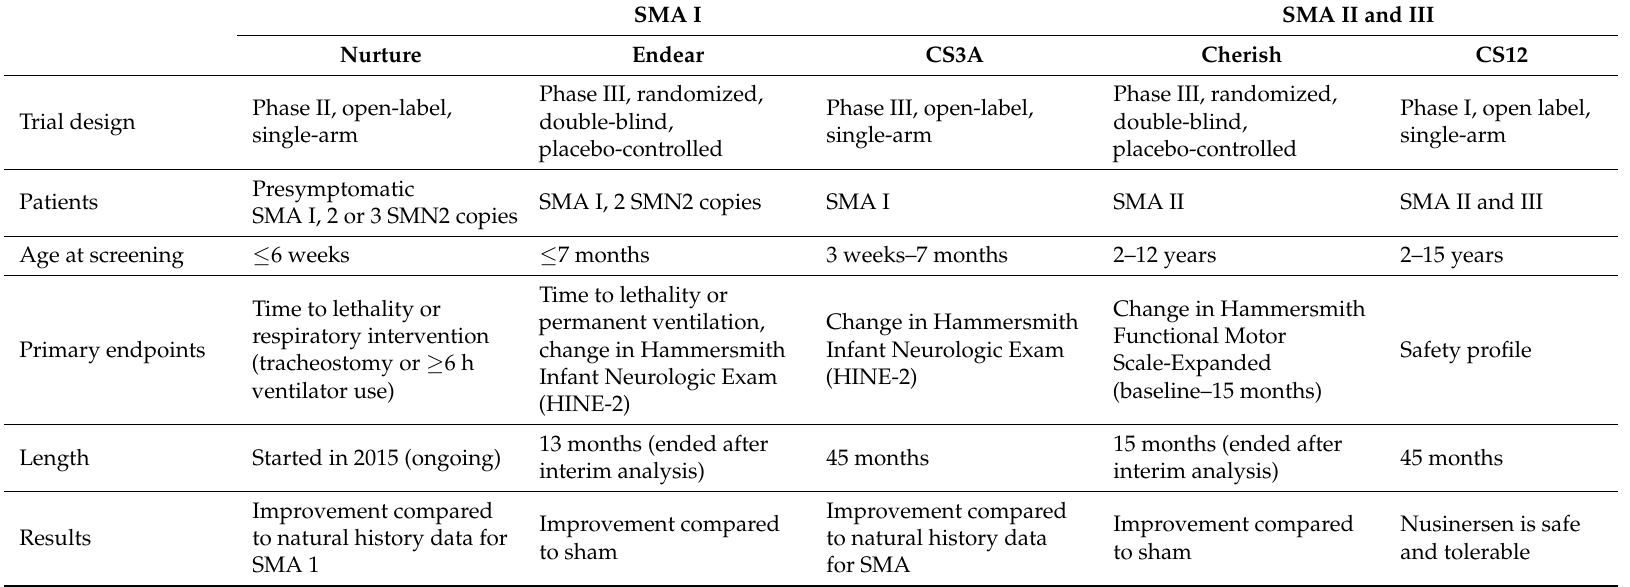
Table 1. Characteristics of different clinical trials with